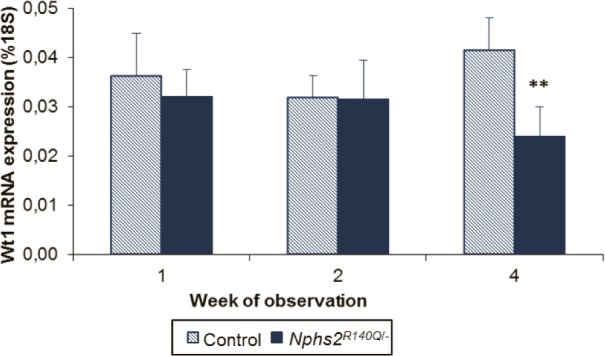
Wt1 regulation in induced animals.Wt1 expression is significantly reduced in Nphs2R140Q/- animals 4 weeks after disease induction (columns represent 5–7 animals per group and time point). **p = 0.0002.